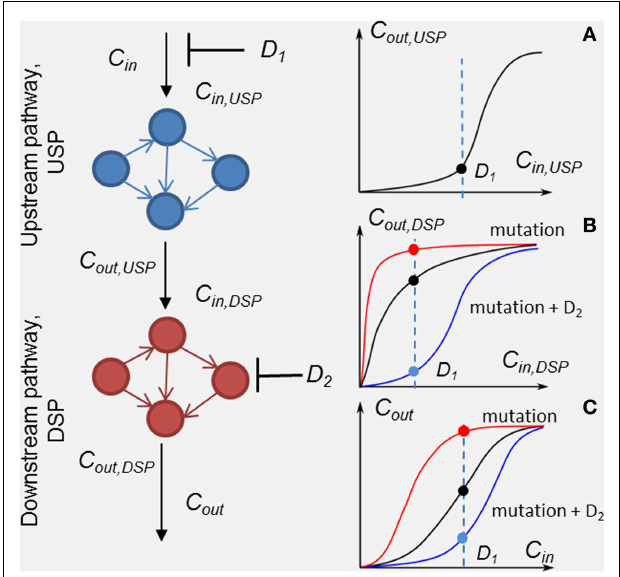
FIGURE 1 | Scheme of the method of customizing cellular signaling response by drug combination targeting upstream (drug D 1 ) and down-stream pathway (drug D 2 ) . Plot sketches A, B, and C show responses, R USP = C out,USP ( C in,USP , D 1 ), R DSP = C out,DSP ( C in,DSP , D 2 ), and the whole SN R SN = C out ( C in , D 1 , D 2 ), respectively. Examples of the responses of unmodified DSP (black line), modified by a mutation in the DSP (red lines) and modified by the second drug D 2 (blue lines) in the presence of the mutation. Input signal C in inhibited by drug D 1 is shown by the dashed